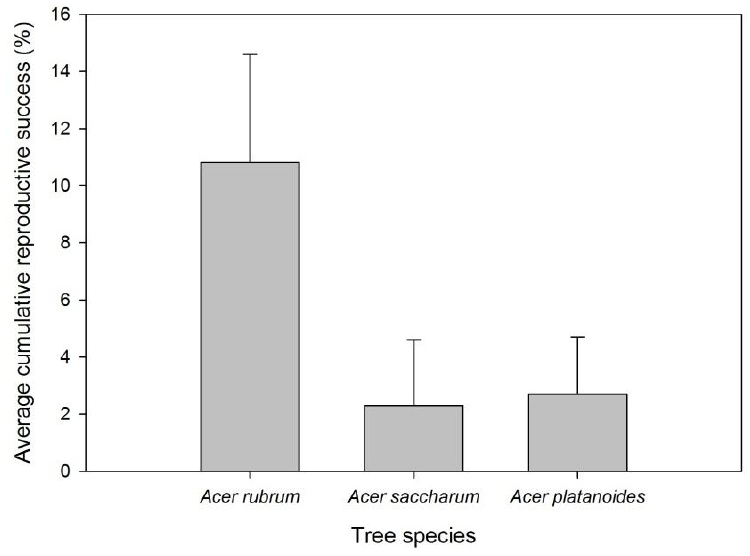
Figure 6. Mean cumulative reproductive success of Asian longhorned beetle by tree species in Boylston. Reproductive success was determined by dividing the number of eggs by exit